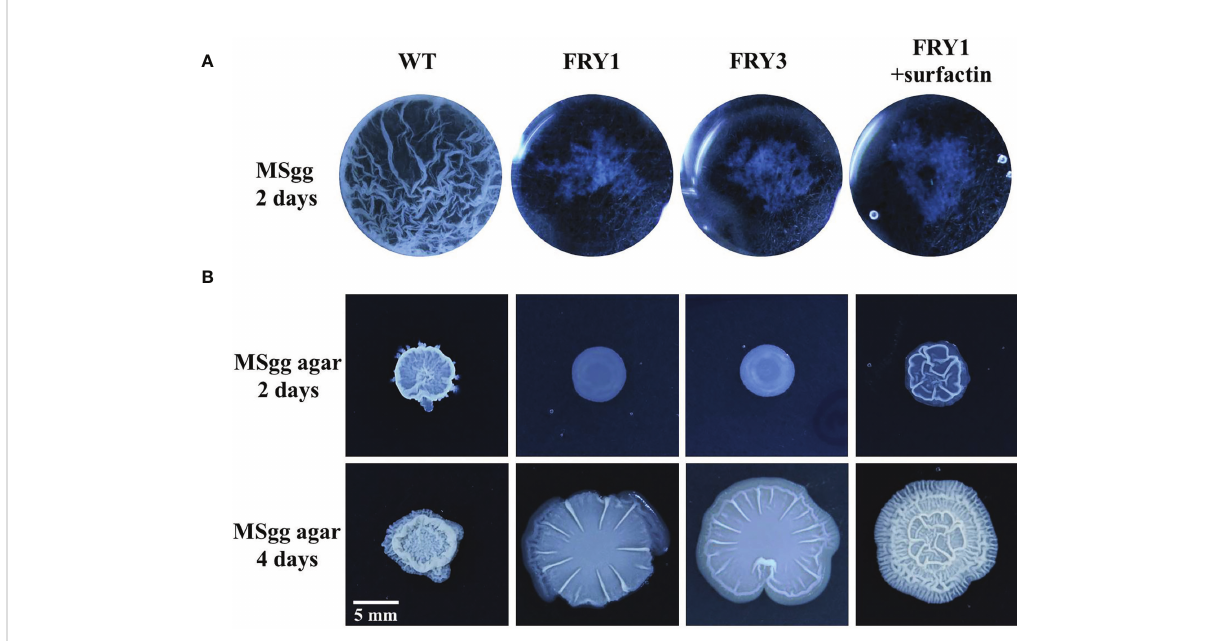
FIGURE 10 The D srf mutants lost the ability to form bio fi lm. (A) WT formed a thick and wrinkled bio fi lm, while D srf mutants did not. Surfactin did not rescue the bio fi lm formation of D srf mutant in liquid MSgg medium. For bio fi lm formation, 10 m l of strains (OD 600 = 1) were added to 1 ml MSgg broth and incubated in a 24-well plate at 30°C for 2 days. The addition of 20 m M of surfactin was to determine if surfactin could rescue bio fi lm formation. (B) For colony morphology, 3 m l of strains (OD 600 = 1) were spotted on the center of MSgg solid medium, and then incubated at 30° C for 2 or 4 days. To determine if surfactin could rescue colony morphology, solution of 5 m l containing 10 m g of surfactin was spotted on the center of MSgg solid medium before adding 3 m l of FRY1 (OD 600 =